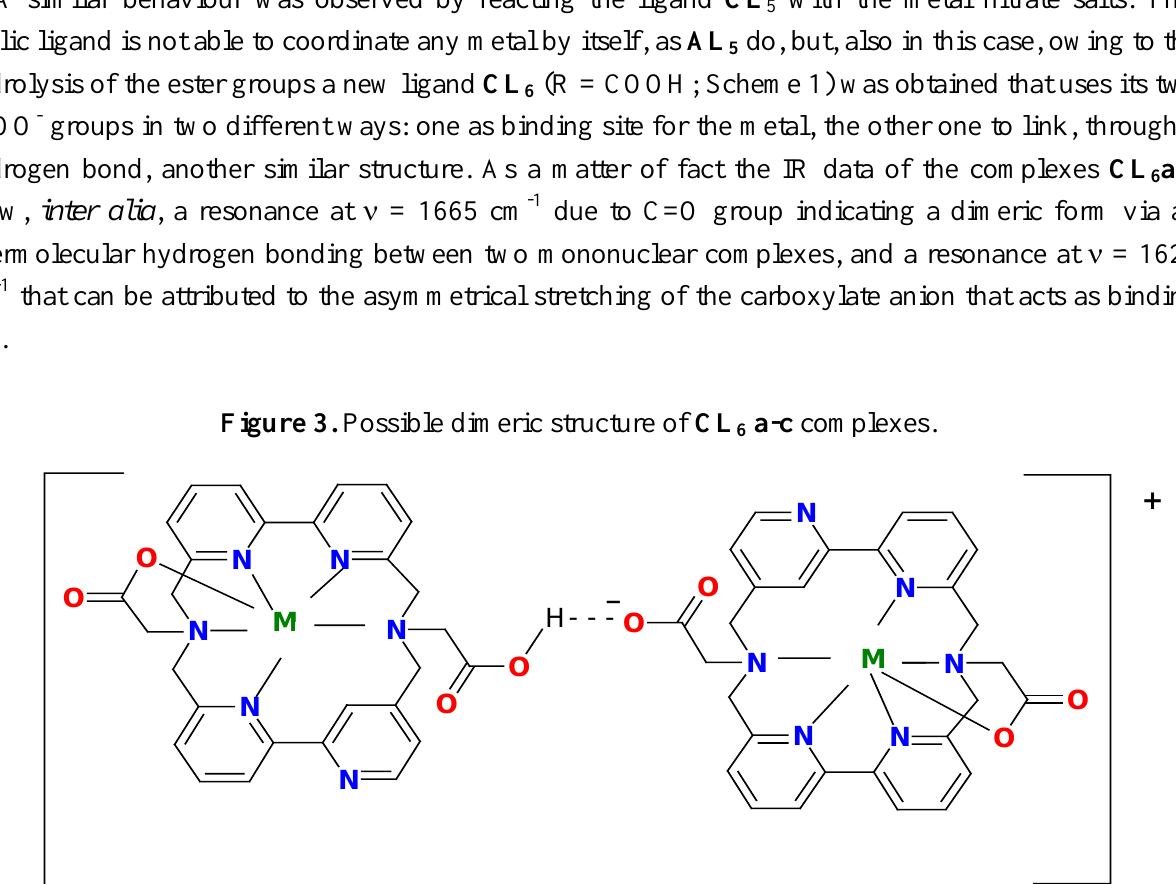
Figure 3. Possible dimeric structure of CL